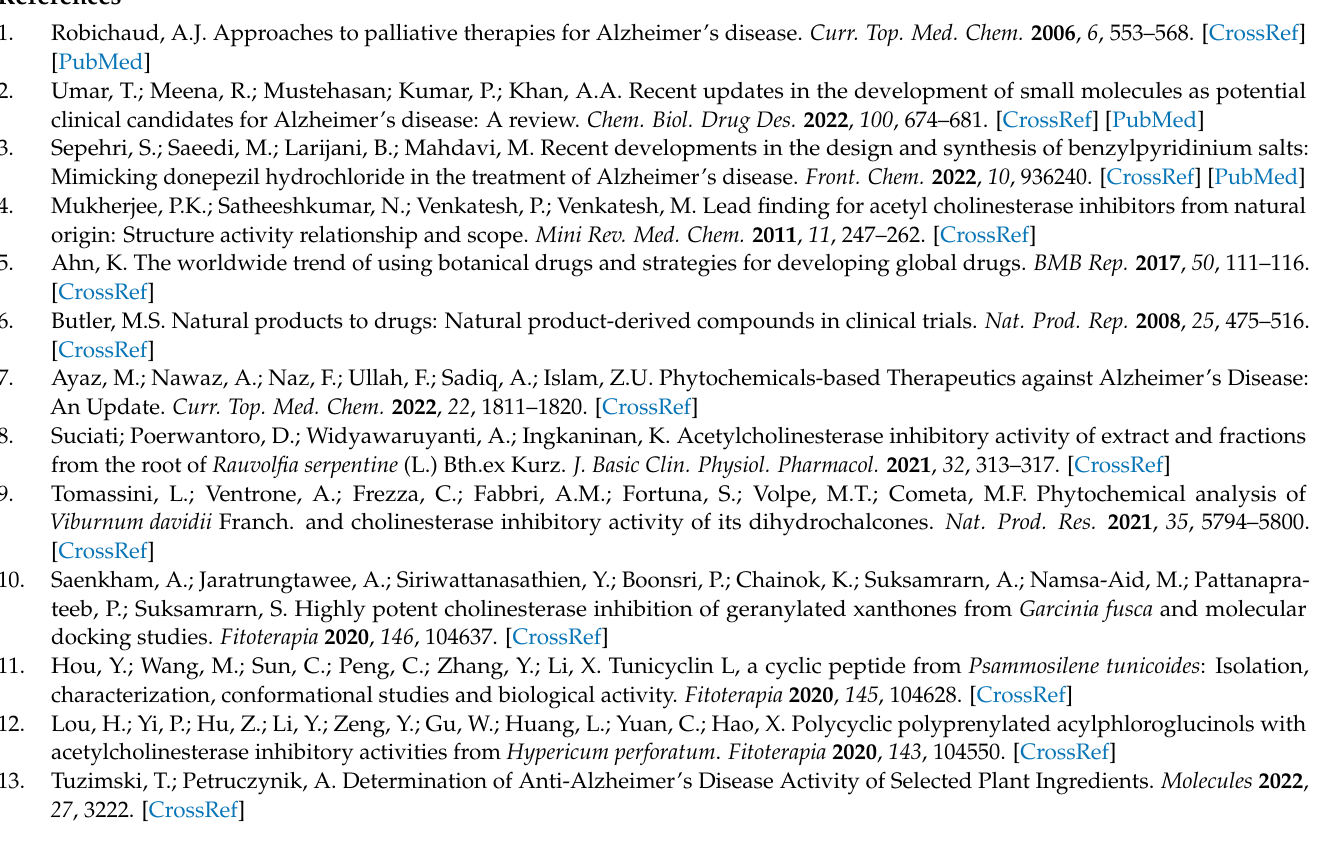
of 6a , b . Supplementary Figure S5.3. The mass spectrum of 6a , b . Supplementary Figure S6.1. 1 H NMR spectrum of 7 . Supplementary Figure S6.2. 13 C NMR spectrum of 7 . Supplementary Figure S6.3. The mass spectrum of 7 . Supplementary Table S1. Chemical structures of lupinine-based esters of dif- ferent carboxylic acids under investigation. Supplementary Figure S7. 2D diagram of ligand-receptor interactions obtained on docking of compound 15 in AChE. Blue dashed lines—hydrogen bonding interactions. Red dashed line—steric interaction. Supplementary Table S2. Chemical formulas, selected ADME parameters of the lupinine-based esters calculated with SwissADME web tool, and manually added indicator variable for the quaternary sp 3 carbon atom (Q). Supplementary Table S3. Experimentally determined, calculated, and LOO-predicted classes for AChE inhibitory activity of the lupinine-based esters of different carboxylic